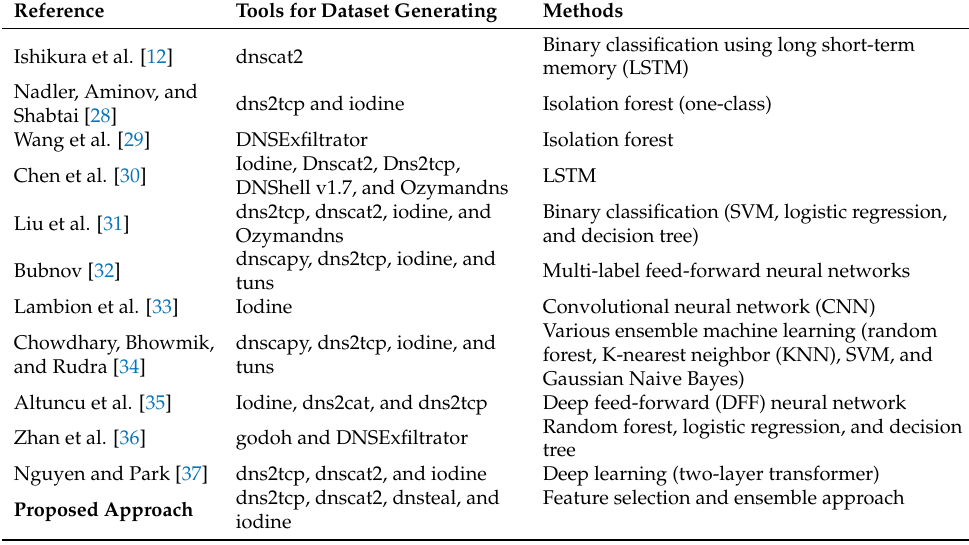
Table 1. Summary of related